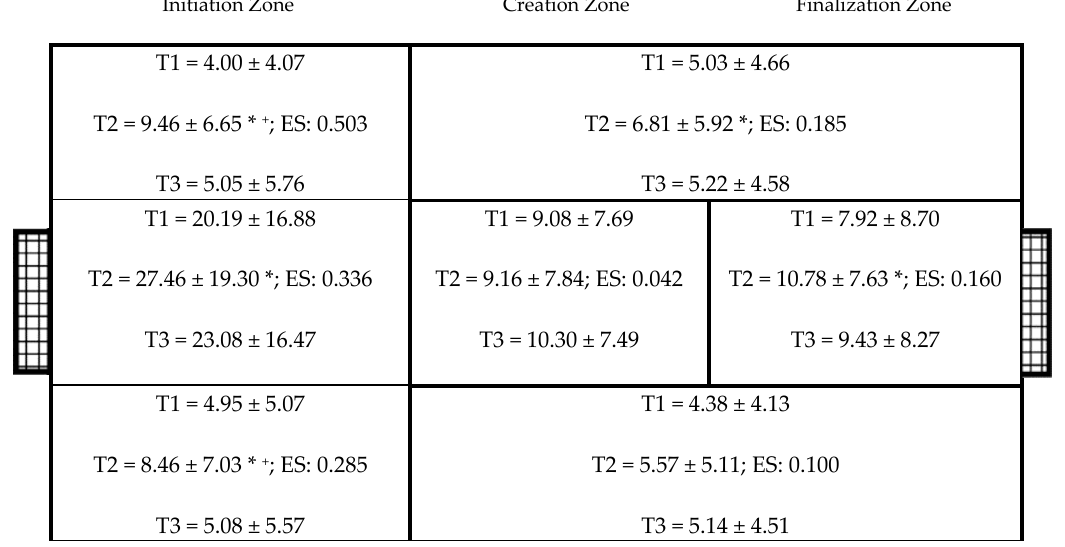
Figure 1. Zones where the player receives the ball. Legend: * Statistically significant differences between Tournament 1 (T1) and Tournament 3 (T3); + Statistically significant differences between Tournament 2 (T2) and Tournament 3 (T3); ES: effect size ( η 2 ).